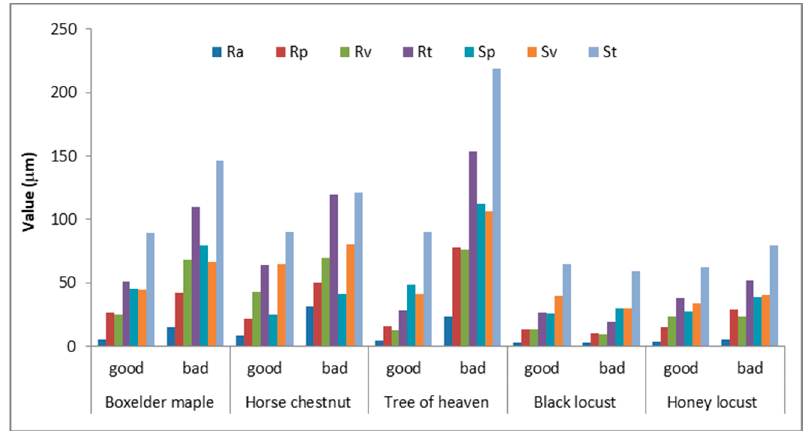
Figure 7. Area and profile roughness parameters for different tree species. “Bad” and “good” designation represents the best and the worst quality surface, respectively. Ra—arithmetic mean of all deviations from the center line over the sampling path, Rp—maximum profile peak height along the sampling length, Rv—maximum profile valley depth along the sampling length, Rt—total height of profile, Sp—height of the highest peak within the defined area, Sv—absolute value of the height of the largest pit within the defined area, St—distance between the largest peak height value and the largest pit depth value within the defined area.